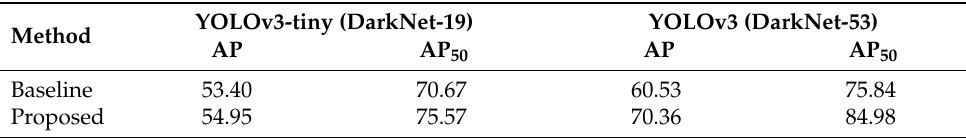
Table 3. Ablation study with various backbone